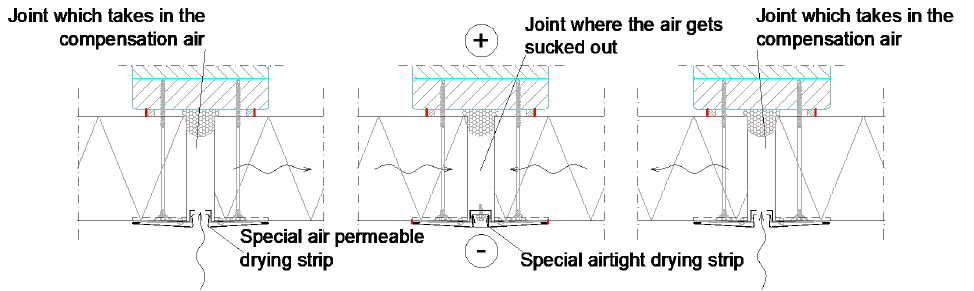
Figure 10. Scheme on top view of facade for ventilated vertical joints and compensation air joints.